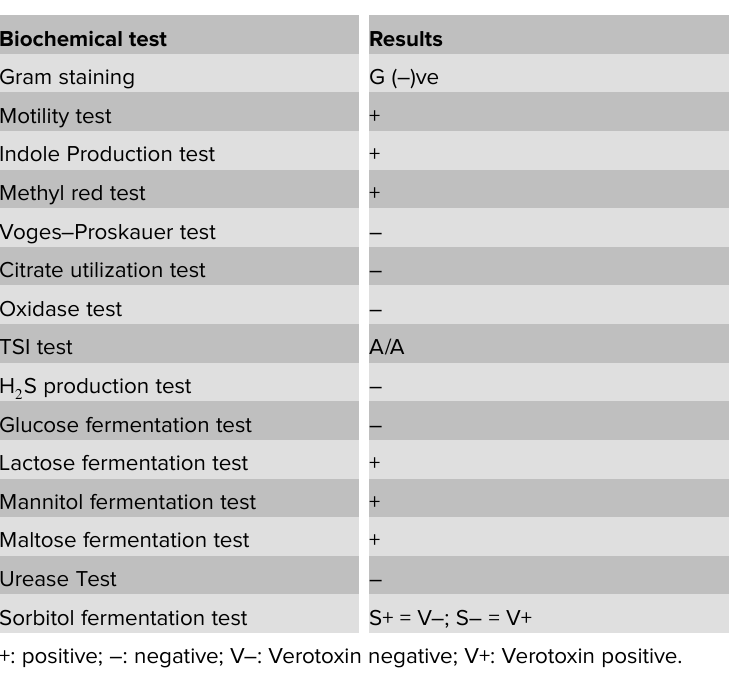
Table 1: Biochemical characterization.